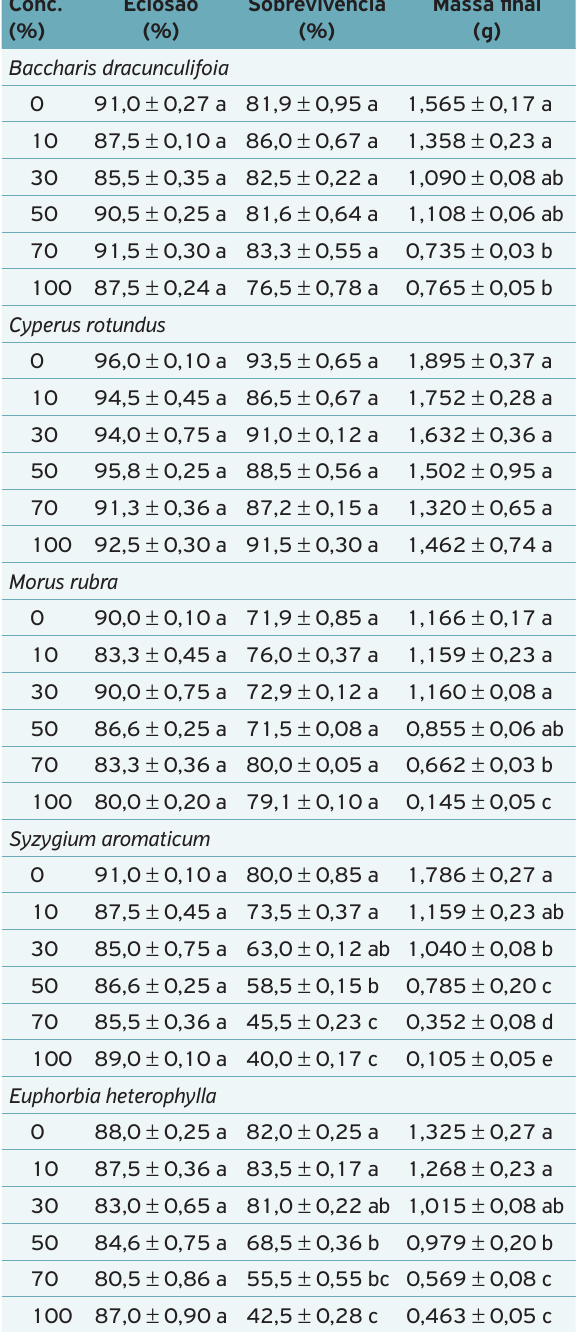
Tabela 1. Eclosão, sobrevivência e massa final de Achatina fulica sob efeito de extratos aquosos de alecrim-do-campo ( Baccharis dracunculifolia DC.), tiririca ( Cyperus rotundus L.), amora ( Morus rubra L.), cravo-da-índia ( Syzygium aromaticum (L.) Merr. & Perry) e leiteira ( Euphorbia heterophylla L.). Muriaé,